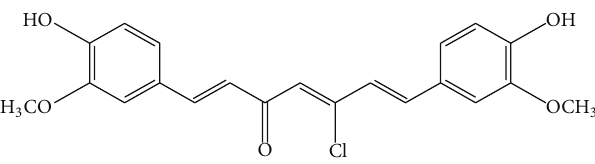
Figure 1: Structure of 5-chlorocurcumin.